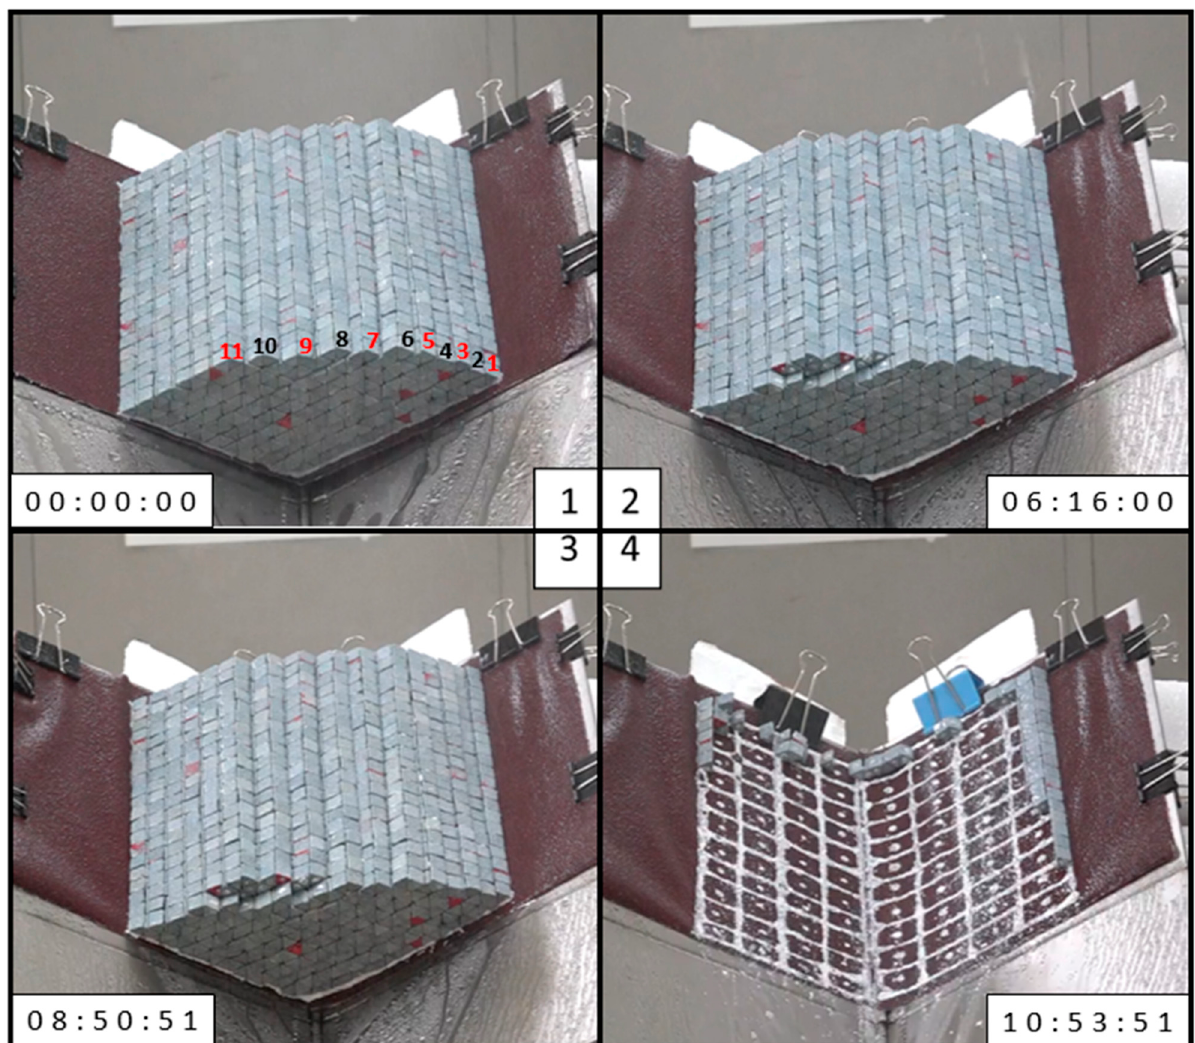
Figure 8. Physical test process of Model C ( i a = 40° and ω 1 = ω 2 = 60°). The primary conditions of Model E were i a = 70 ◦ and ω 1 = ω 2 = 25 ◦ , and the duration of the test was 3 h 24 min 03 s (Figure 10). At the first stage (the initial deformation stage; 00:00:00–01:44:39), the model softened because of rainfall infiltration, and the greater intersection angle meant that gravity exerted a greater impact on the model. Significant deformation was observed after 20 min of rainfall. The weak planes in the oblique slope were inclined towards the right plate, and, as a result, soon after the surface water had infiltrated the model, the surface layer at the slope toe on the right plate (locations No. 7–10) showed local collapses and toppling failure. During the second stage (the local rock mass failure stage; 01:44:40–03:14:12), as some of the rock at the slope toe on the right plate collapsed, the rock on the right plate also became unstable, gradually resulting in wedge failure. Approximately 30% of the rock wedge slid and collapsed along the slope, greatly reducing the support below the rock mass on the right plate. Losing its support on the right, the entire rock wedge relied on the rock on the left plate and the intersection line for support. Then, as the duration of surface water infiltration increased, gravity and the weakening of the rock near the left led to gradual leaning and deformation. Subsequently, the rock in the back collapsed and toppled on a large scale along the intersection line, and only 5% of the rock remained on the slope. The duration of the Model F ( i a = 70 ◦ and ω 1 = ω 2 = 45 ◦ ) test was 7 h 49 min 14 s (Figure 11). At the first stage (the